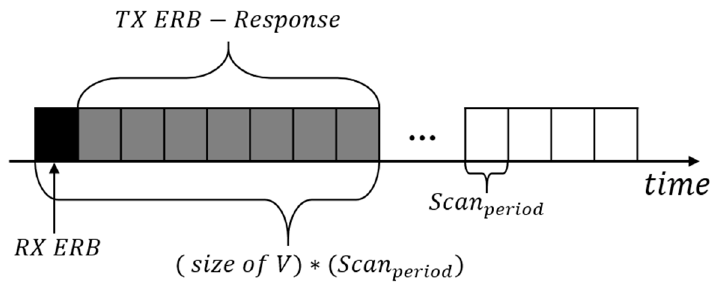
Figure 9. ERB Response Transmission Point.